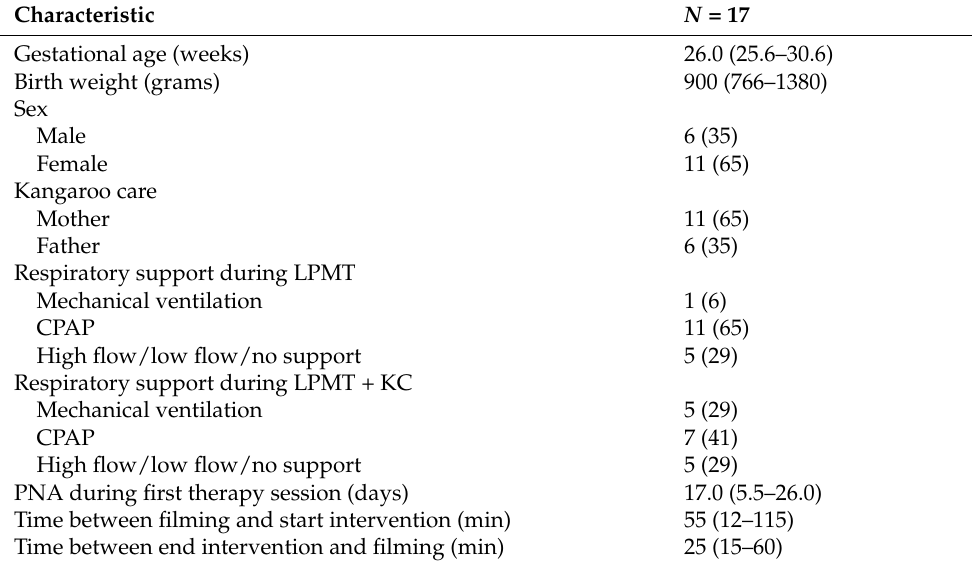
Table 1. Baseline patient characteristics for infants that completed both